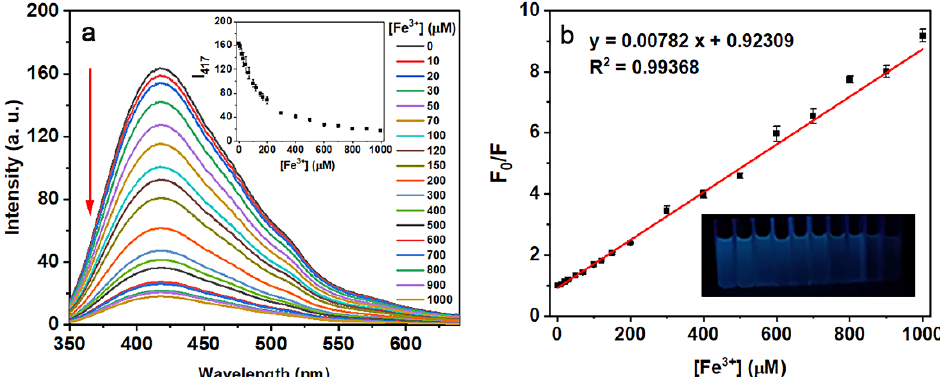
Figure 9. ( a ) Fluorescence spectra of the N-CQD-13 (80 mg/L) solutions treated with different concentrations of Fe 3+ . (Inset: Intensity changes at 417 nm with the different concentrations of Fe 3+ ). ( b ) The Stern – Volmer plot of adding different concentrations of Fe 3+ (0 – 1000 μM) to the N-CQD-13 (80 mg/L) solutions.